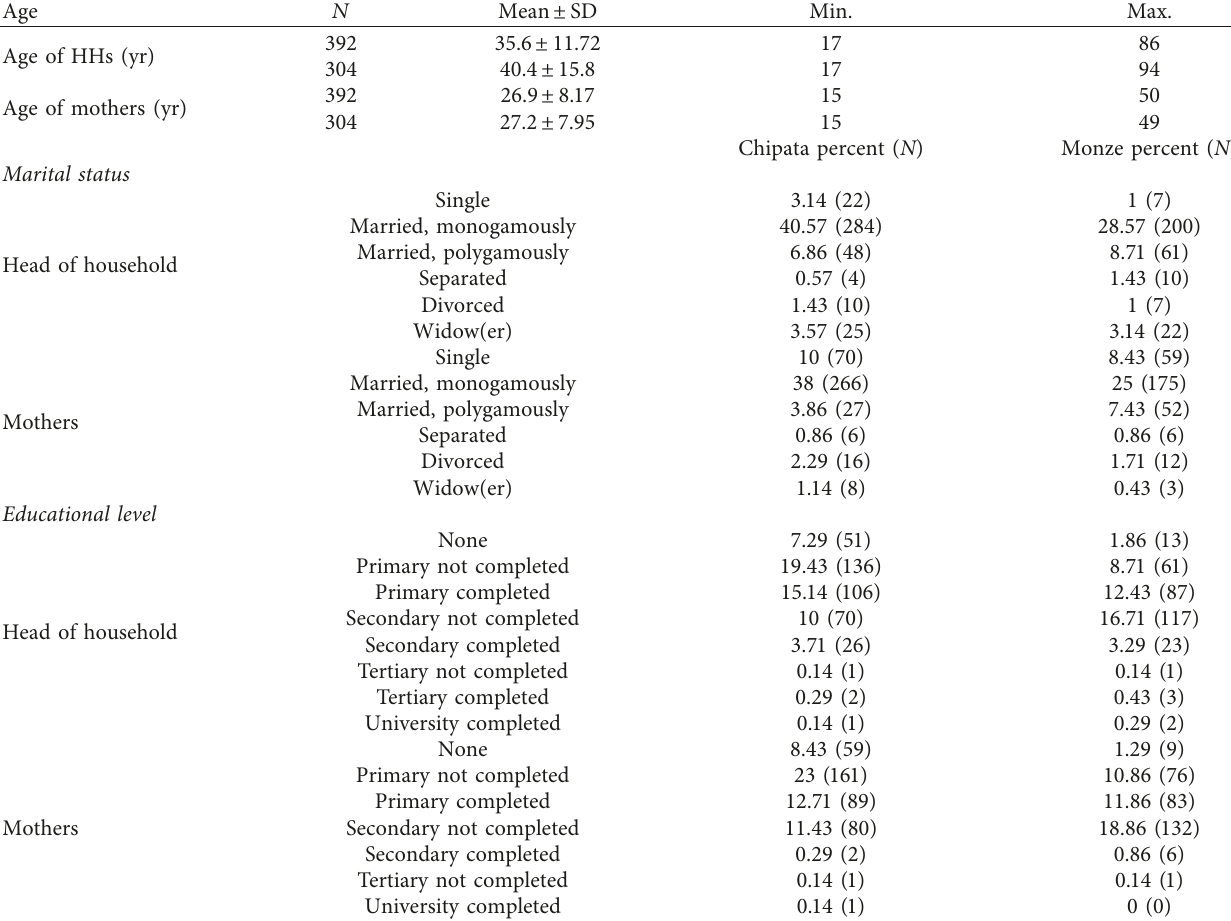
Table 1: Sociodemographic characteristics of household heads (HHs) and mothers from Chipata and